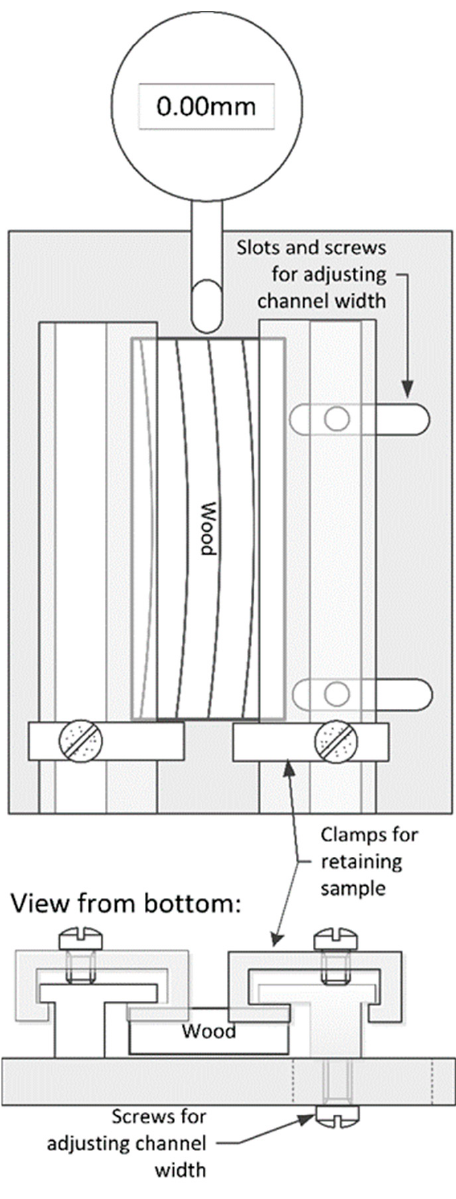
Figure 1. Front and bottom views of swellometer jig.